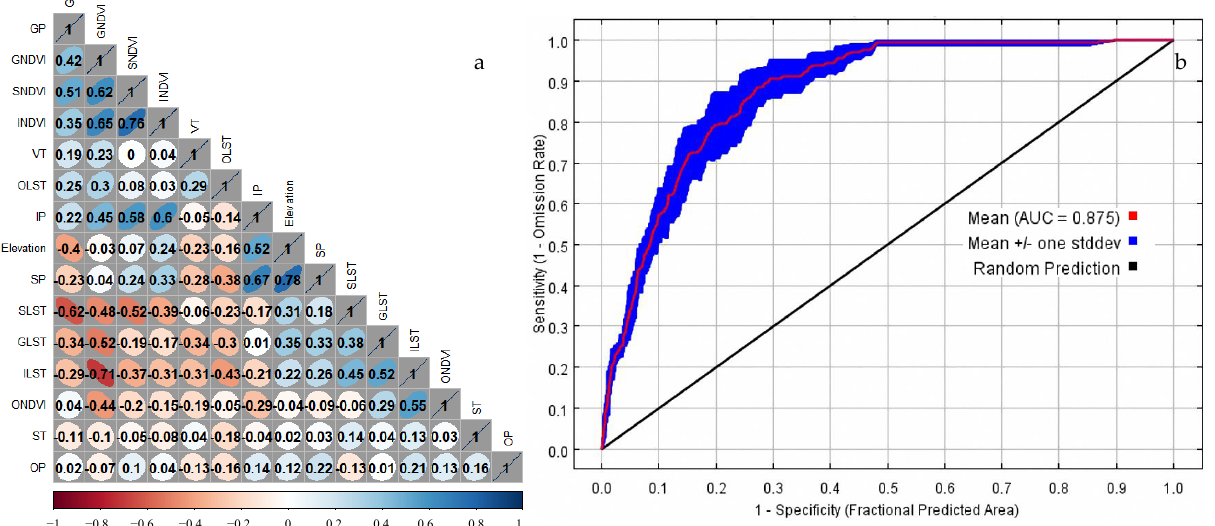
Figure 3. The correlation of each habitat factor ( a ) and ROC curves in MaxEnt model ( b ). The red and blue lines are the fit of MaxEnt model for training and testing data, respectively.